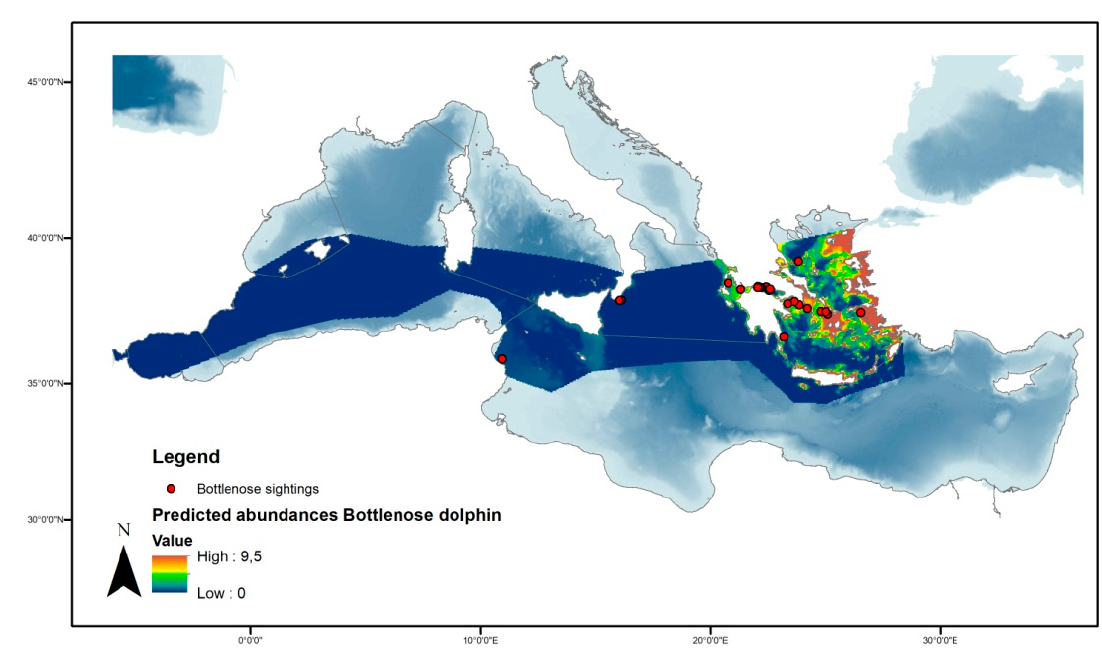
Figure 8. Spatial prediction of abundance for bottlenose dolphins per cell in the studied area.